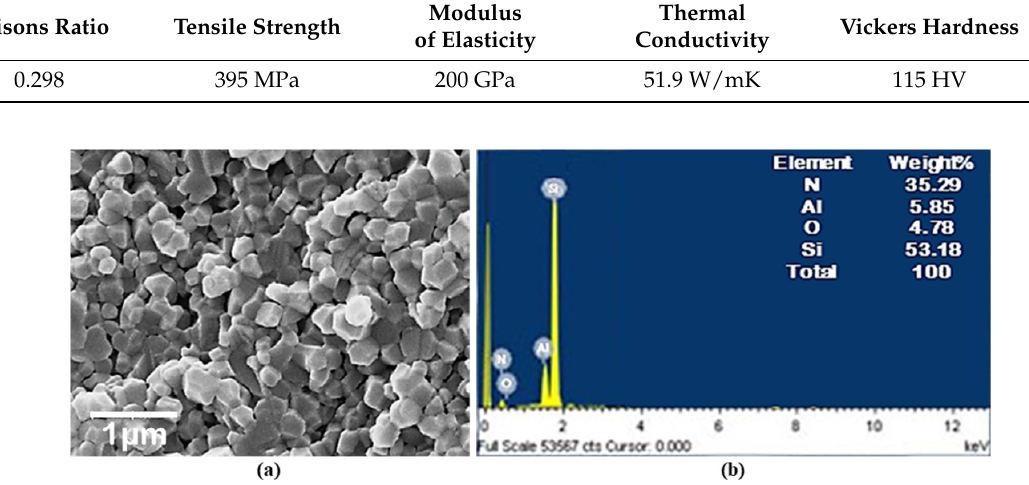
Figure 1. SEM/EDX image of Nitronic 60 steel. Table 1. Properties of Nitronic 60 [34] .